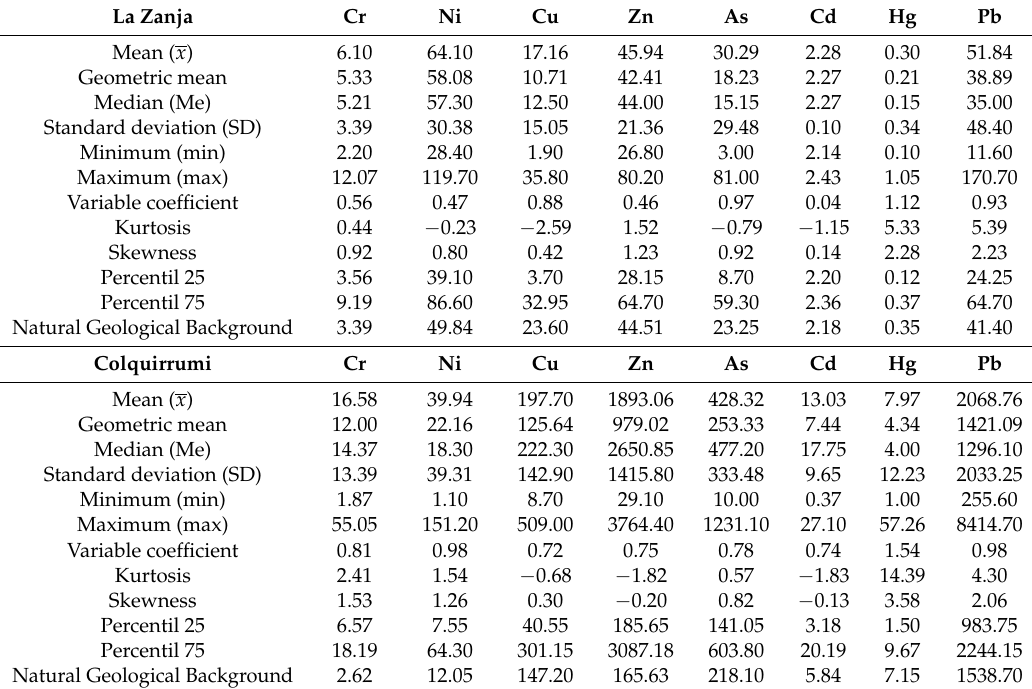
Table 2. Statistical analysis of heavy metals in the surface horizons of